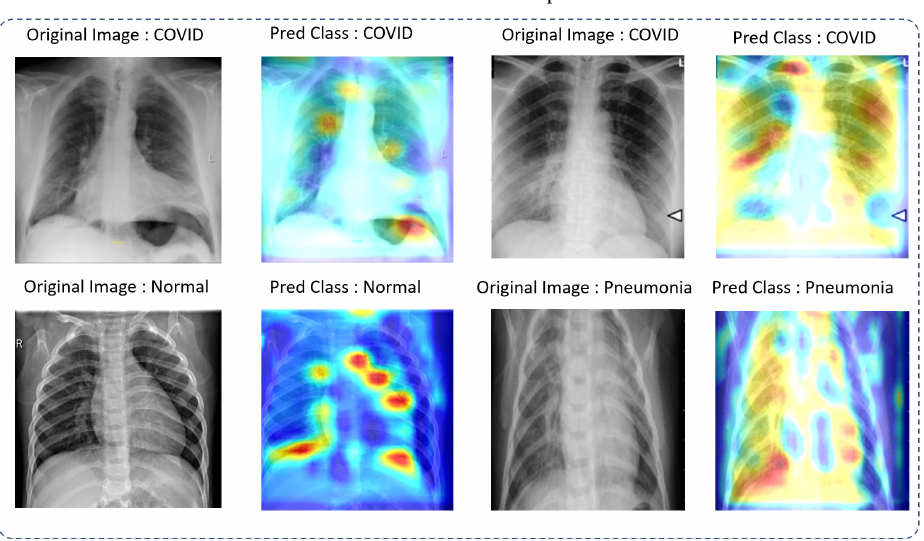
Figure 9. Examples of well-classified samples with Score-CAM.